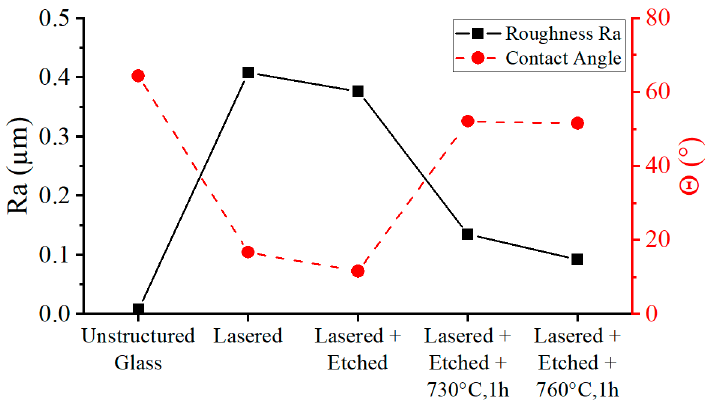
Figure 4. The roughness and contact angle values on glass surfaces measured after the individual glass treatment steps.